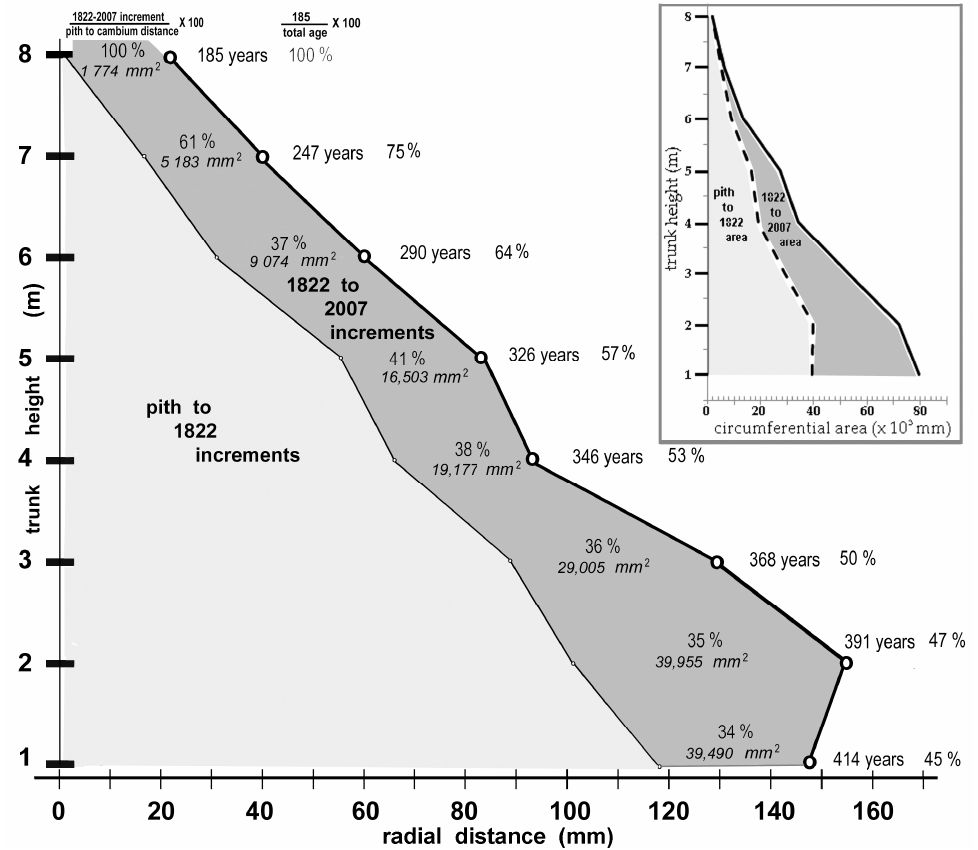
Figure 15. The gišogenetic contributions in terms of radial distance and circumferential area made to secondary growth at eight trunk heights in tree 1311 during the calendar-year period 1822–2007. Area contributions were calculated by summing the radii distances of the four cardinal directions and treating the mean value as the radius of a circle.